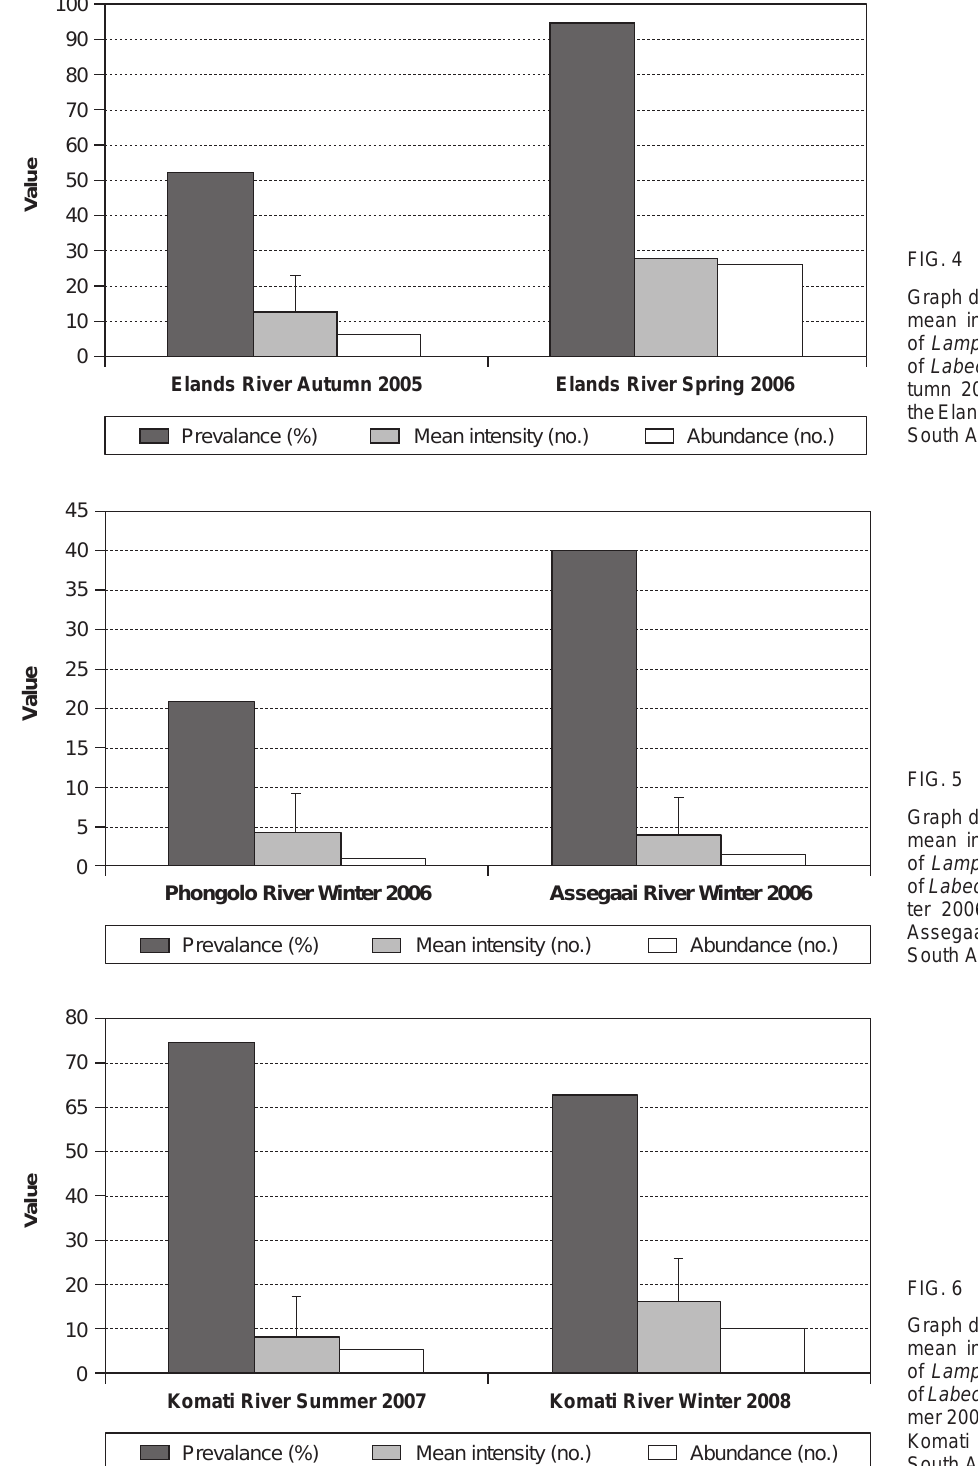
Graph depicting the prevalence, mean intensity and abundance of Lamproglena hoi on the gills of Labeobarbus polylepis in au- tumn 2005 and spring 2006 in the Elands River in Mpumalanga, South Africa